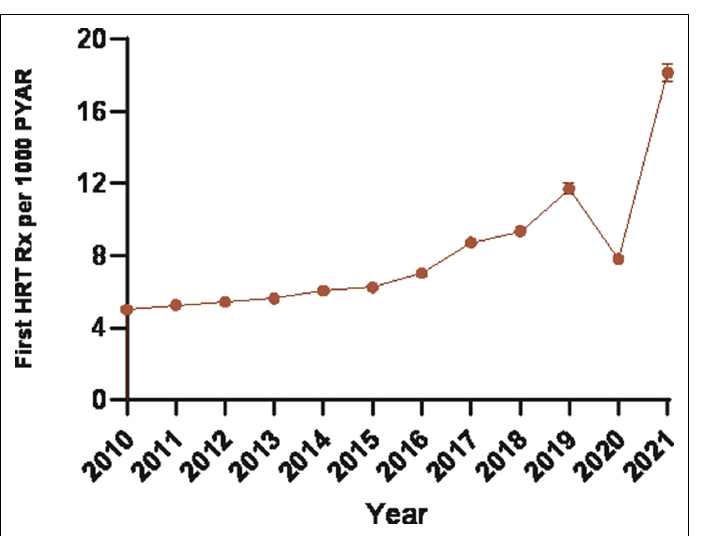
Figure 1 Annual incidence rate of prescribing of HRT medicines. HRT = hormone replacement therapy. PYAR = person- year- at- risk. Rx =